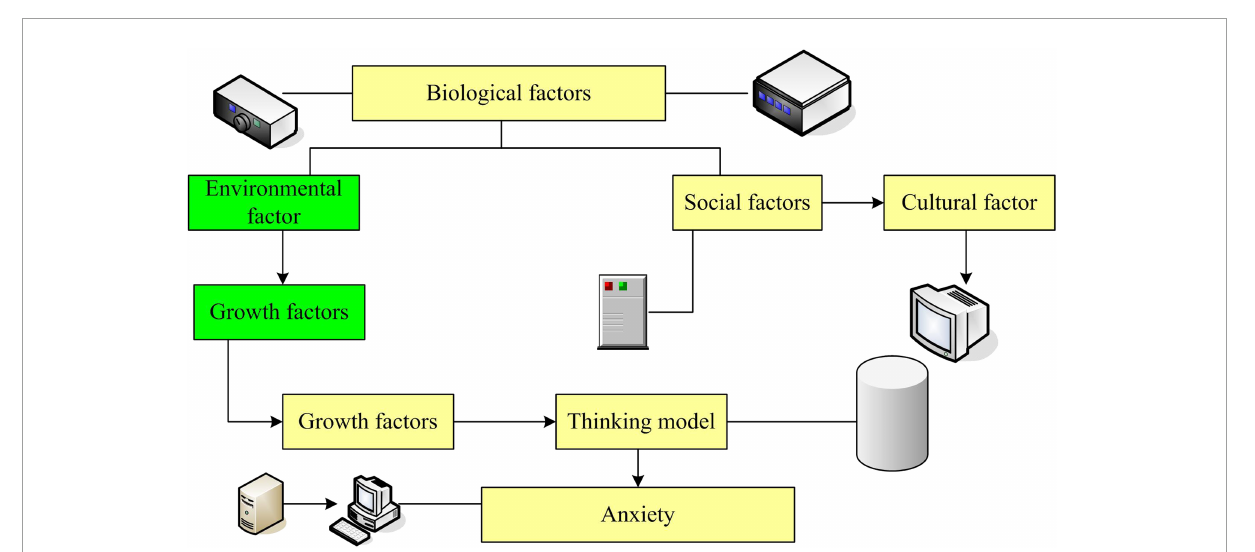
FIGURE1 Factors influencing anxiety.